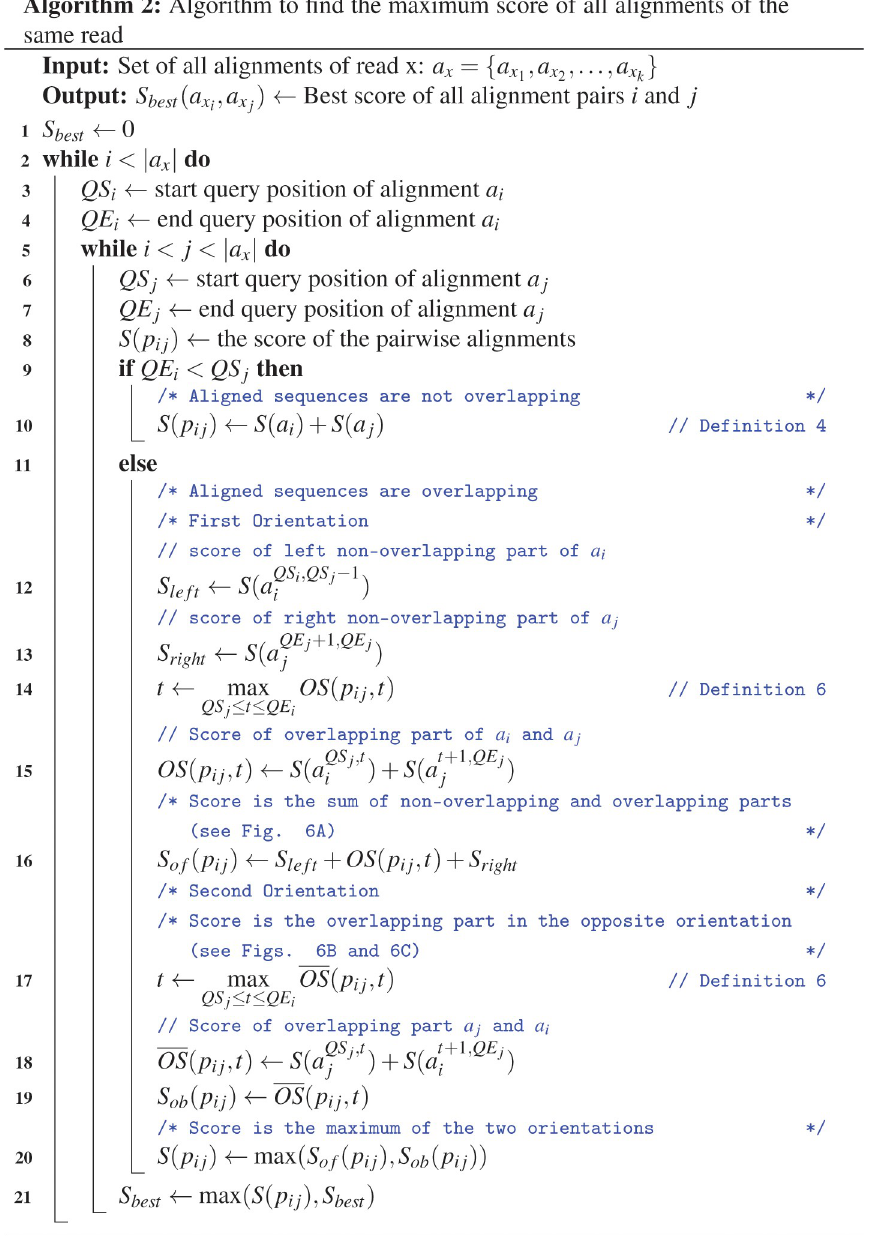
Fig 4. Algorithm 2 pseudocode to calculate the maximum score path. Depicted is the pseudocode of algorithm 2, looping through all the possible combinations of pairs of ‘i’ and ‘j’ alignments, calculating the score of each combination and retaining the best score overall. To calculate the score, each pair is inspected for an overlapping region (if it exists) and calculates the score for different orientations. The best pair of alignments is selected based on the highest